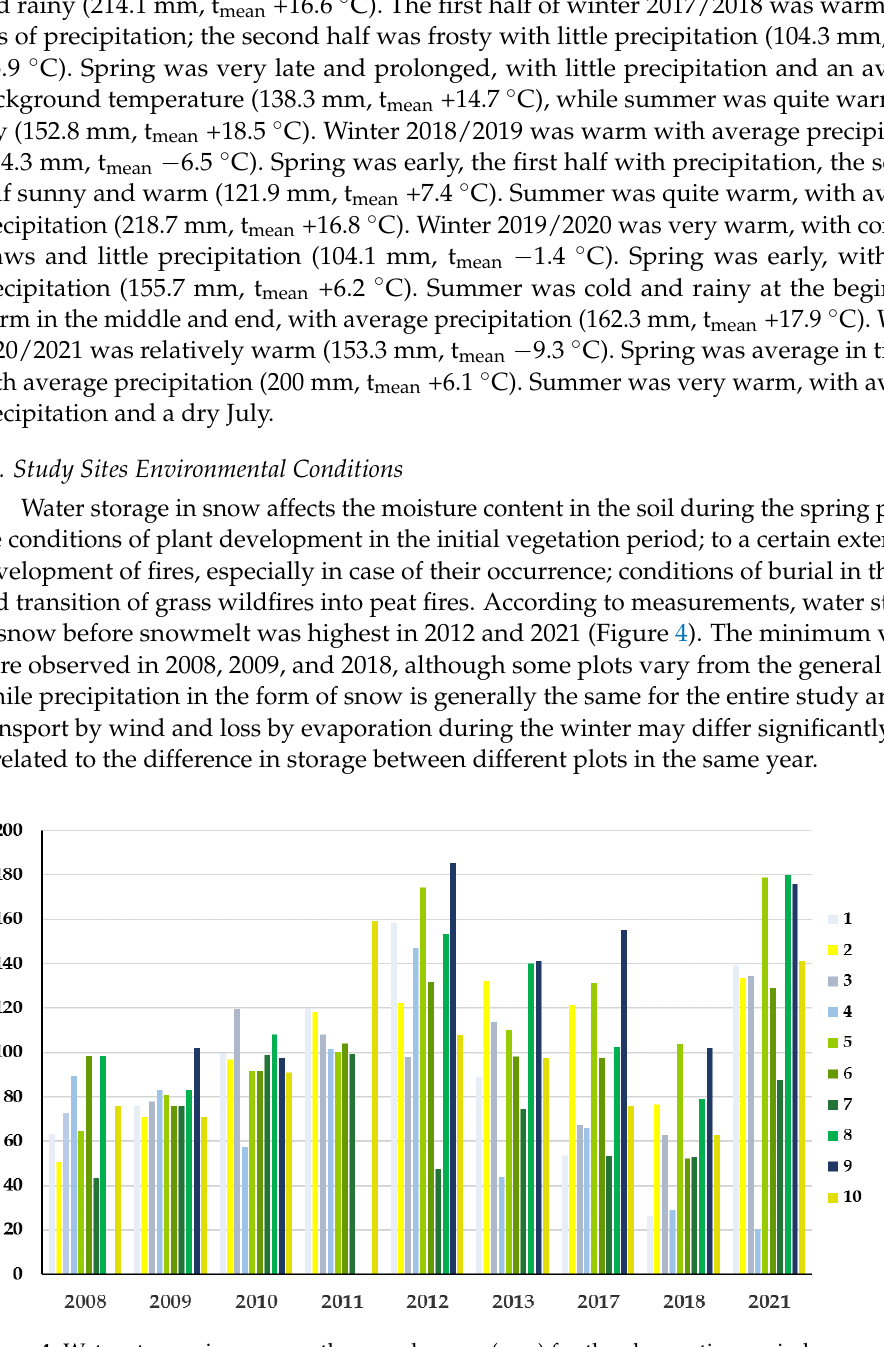
Figure 4. Water storage in snow on the sample areas (mm) for the observation period.